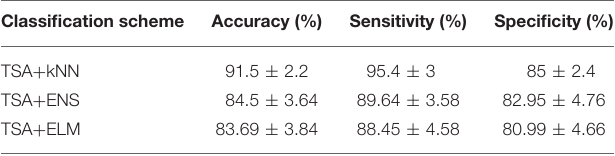
TABLE 1 | Summary of ICFCGs classification performance based on 10-fold cross-validation of TSA for feature selection and kNN, ENS, ELM for classification. Classification